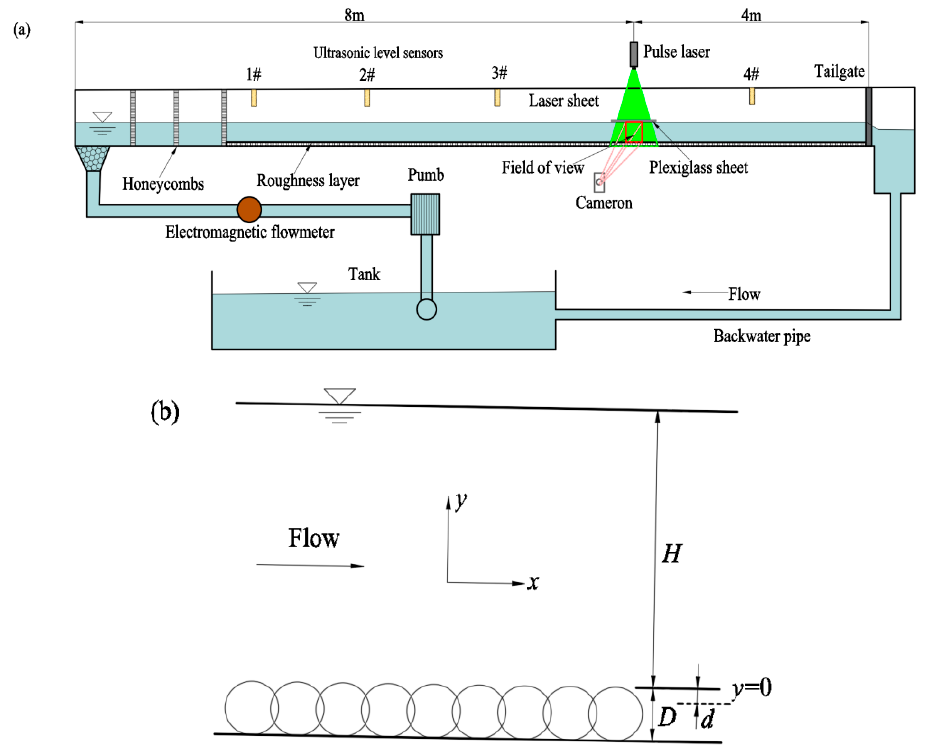
Figure 1. ( a ) Schematic of the open-channel flume. ( b ) Definitions of flow depth H and zero-plane displacement d .